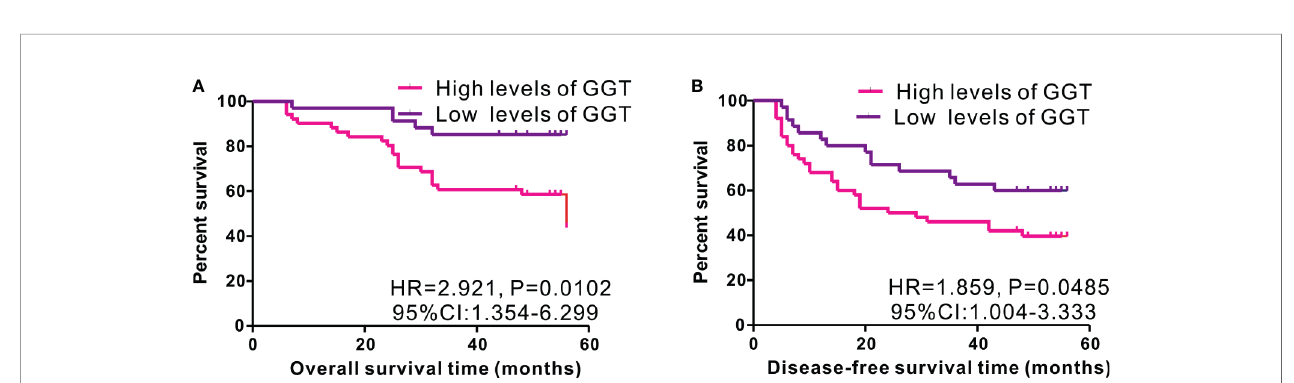
FIGURE 4 | Kaplan-Meier curves of survival in 85 cases of early-stage HCC patients from Renmin cohort strati fi ed by median level of serum GGT protein. High expression of serum GGT protein predicted inferior OS (A) , while not for DFS (B) in HCC patients with curative